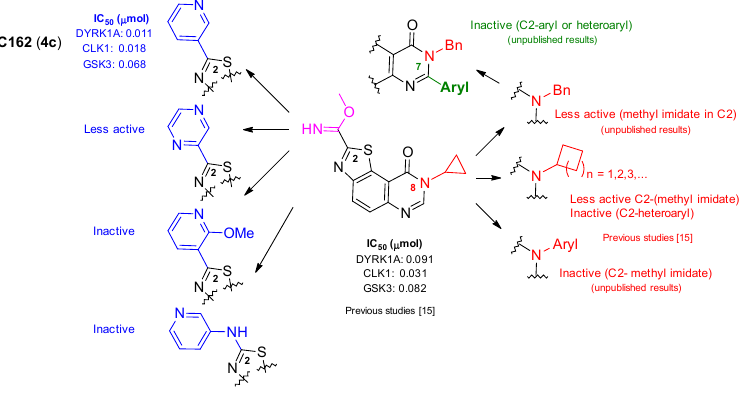
Figure 3. Comparative study of the activity of FC162 ( 4c ) with related molecules.